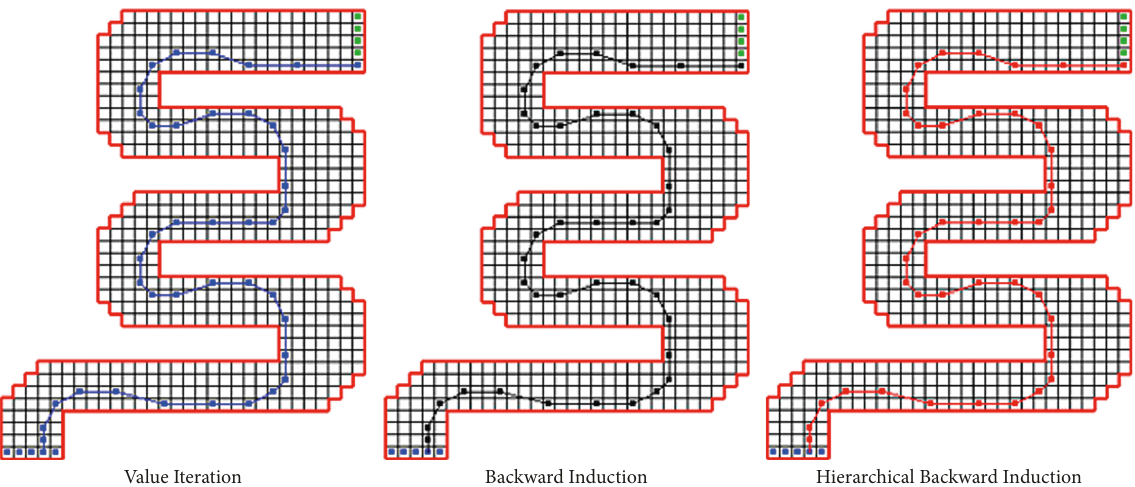
Figure 5: Road generated by VI, BI, and HBI algorithms for the